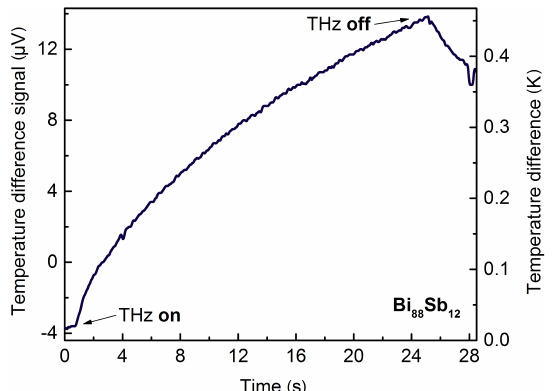
Figure 5. First experiment (photothermal effect). The temporal dependence of a temperature gradient in 200 nm Bi 88 Sb 12 film on the terahertz (THz) field exposure